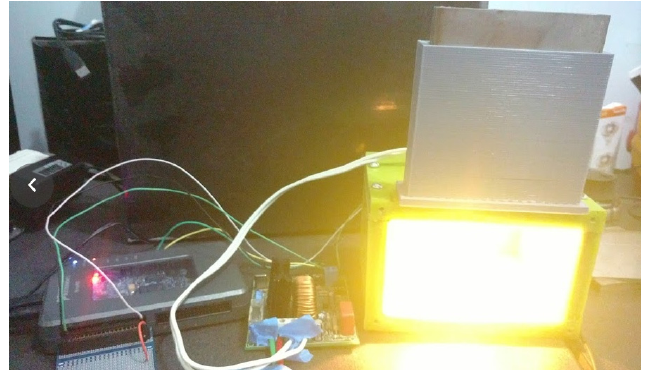
Figure 6. PID control of the controlled temperature camera.